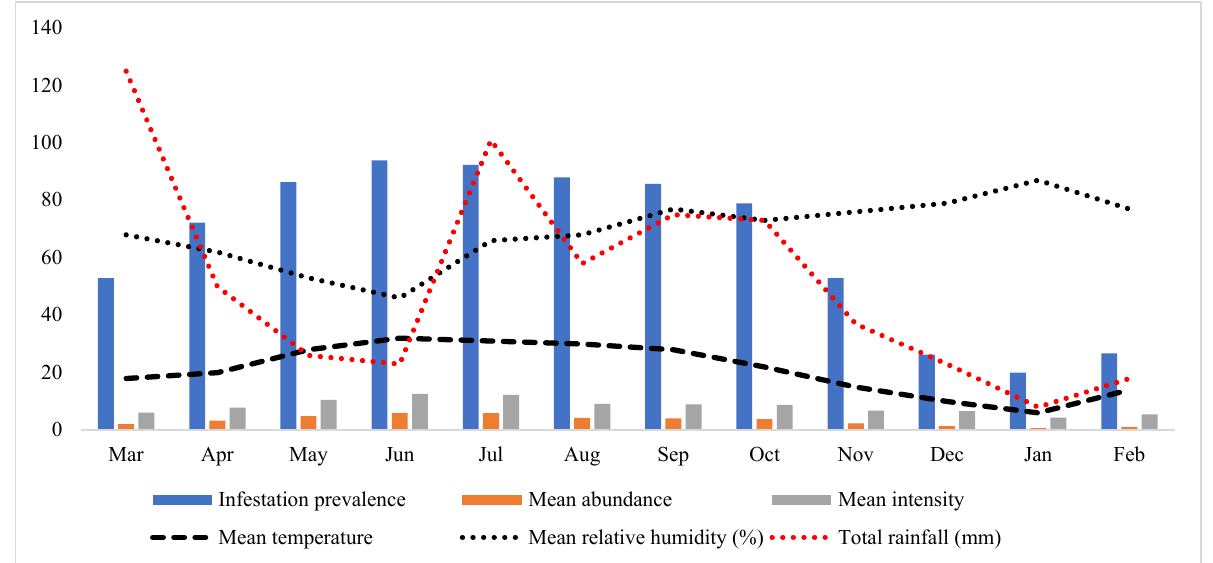
Figure 2. The graph shows the variation in prevalence, mean abundance, and mean intensity related to mean temperature, mean relative humidity, and the total rainfall during this study.